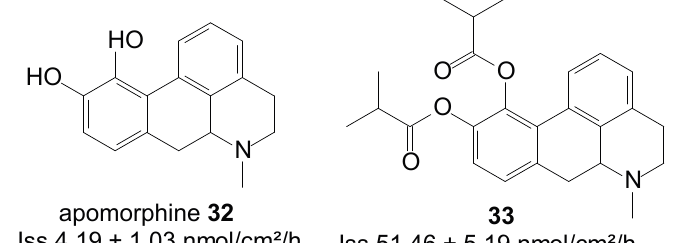
Figure 8. Apomorphine, its diester prodrug, and their respective skin permeation fluxes. NHO NOO HO O O apomorphine 32 33 Jss 4.19 ± 1.03 nmol/cm²/h Jss 51.46 ± 5.19 nmol/cm²/h